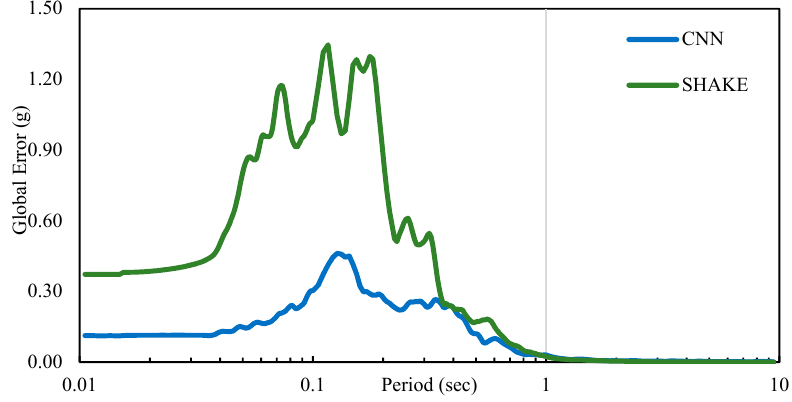
Figure 23. The global average errors of the earthquake predictions for all sites.